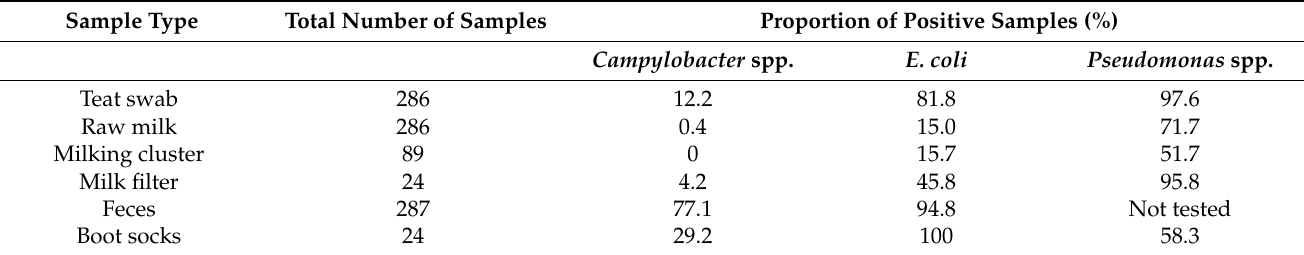
Table 1. Prevalence data for all sample types and taxa